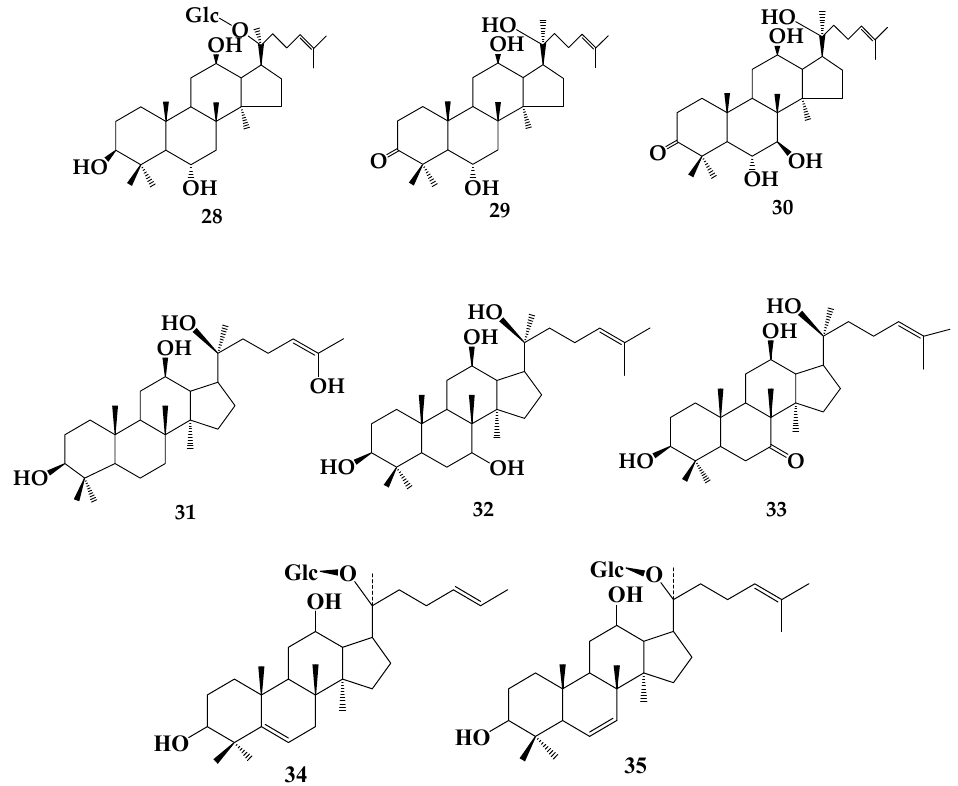
Figure 6. The chemical structures of compound 28 – 35